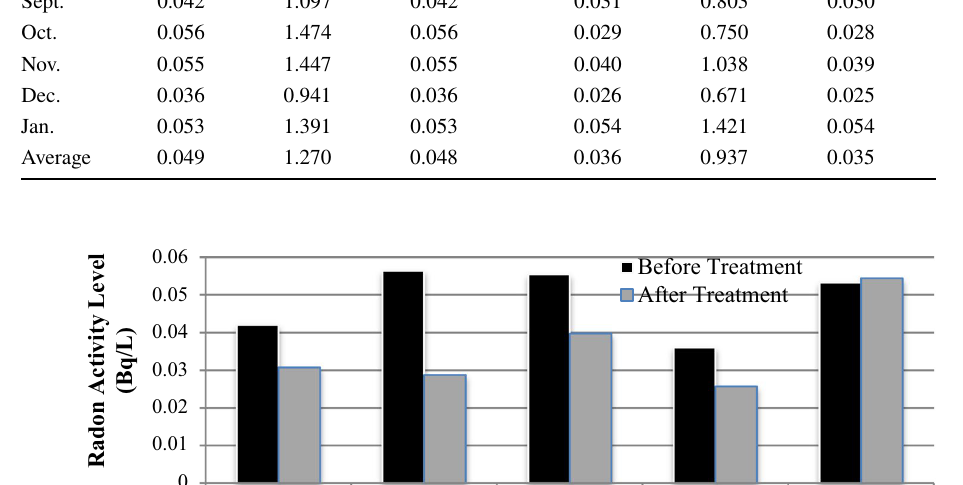
Table 1 C C Rn , dis , and RER S for wastewater samples before and after treatment